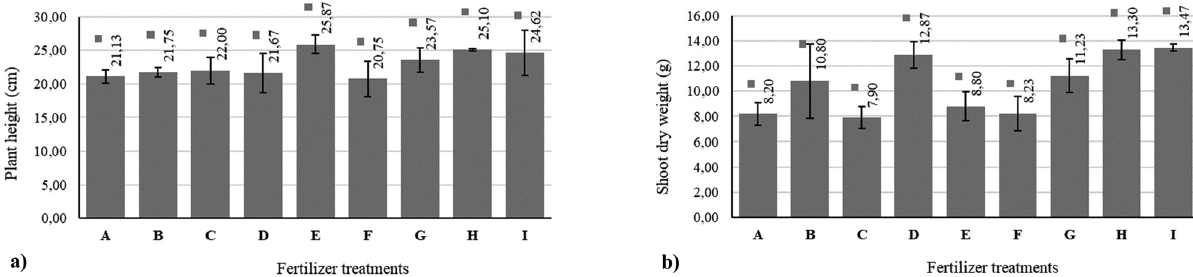
Figure 1: E ff ect of biofertilizer on plant height ( a ) and shoot dry weight ( b ) of nutmeg seedling at 24 weeks after transplanting in the greenhouse. A: control, B: 0.15% BB foliar spray, C: 0.15% BB soil application, D: 0.3% BB foliar spray, E: 0.3% BB soil application, F: 0.5% MB foliar spray, G: 0.5% MB soil application, H: 1% MB foliar spray, I: 1% MB soil application. BB: bacillus biofertilizer, MB: mixed